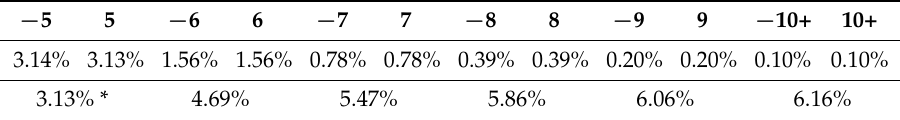
Table 2. Tails of the n day distribution (probability of success assumed equal to 50%).